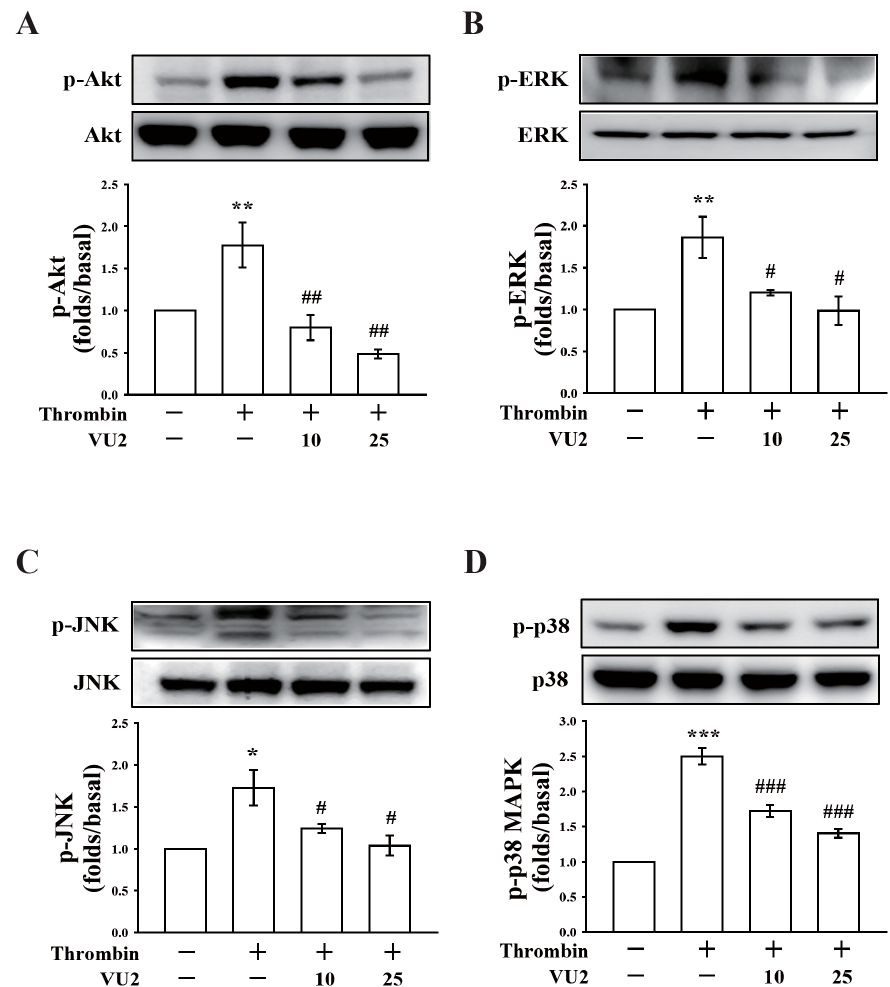
Figure 4. Effects of VU2 on the phosphorylation of Akt and MAPKs. Washed platelets (1.2 × 10 9 cells/mL) were preincubated with DMSO or VU2 (10 and 25 µ M), and thrombin (0.01 U/mL) was